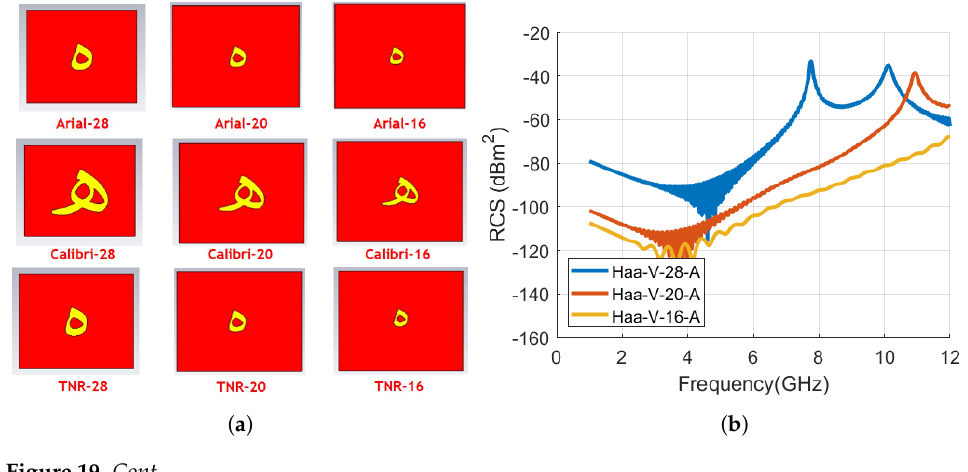
Figure 19. Cont . Figure 19. Cont